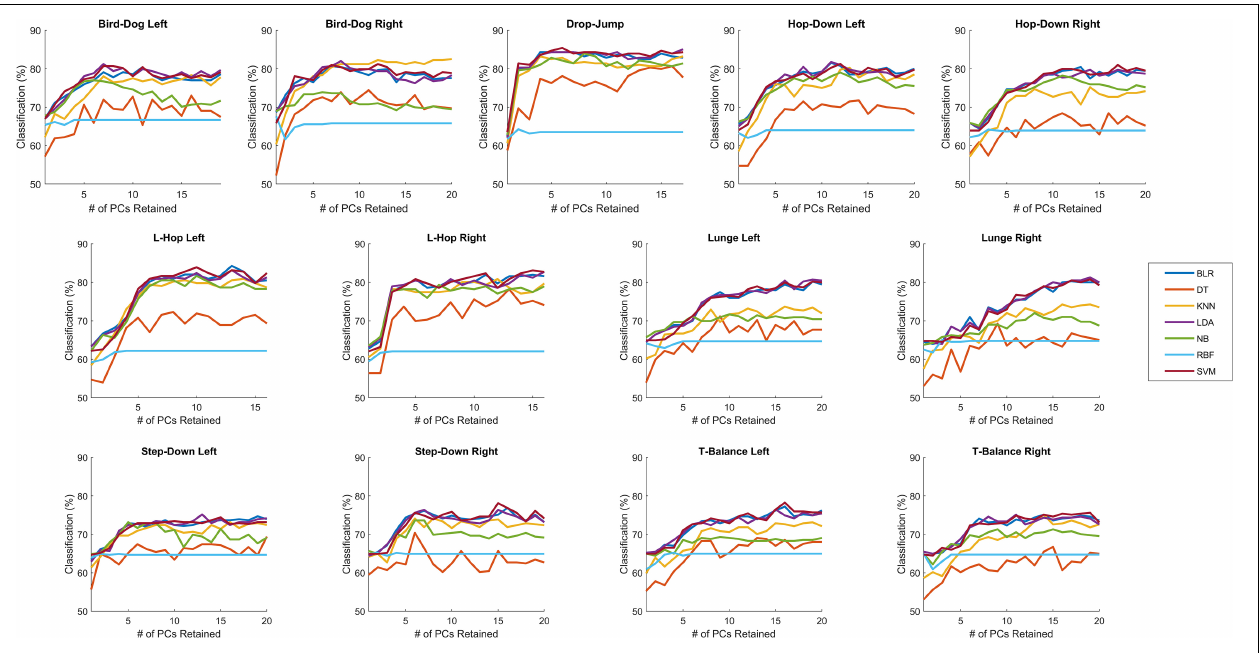
FIGURE 3 | sIMU: The percent of correctly classified athletes as either elite or novice for when 1 to the total number of PCs retained were retained for binary logistic regression (BLR), decision tree (DT), linear discriminant analysis (LDA), k-nearest neighbors (kNN), naïve Bayes (NB), support vector machine with a linear kernel (SVM), and support vector machine with a radial basis function kernel (RBF) with leave-one-out validation for sIMU. See number of PCs retained in Table 2 .